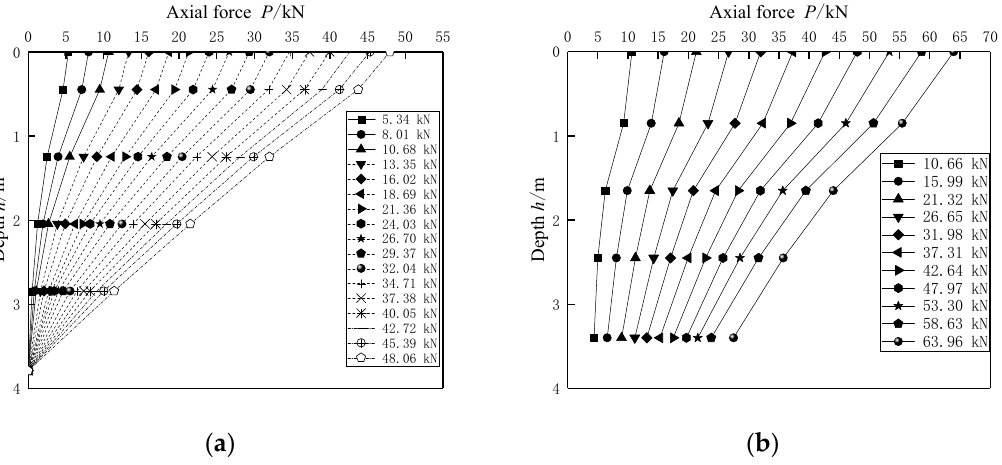
Figure 6. Axial force distribution curve of test pile body: ( a ) the pile-end soilless compressive pile and ( b ) the conventional compressive pile.